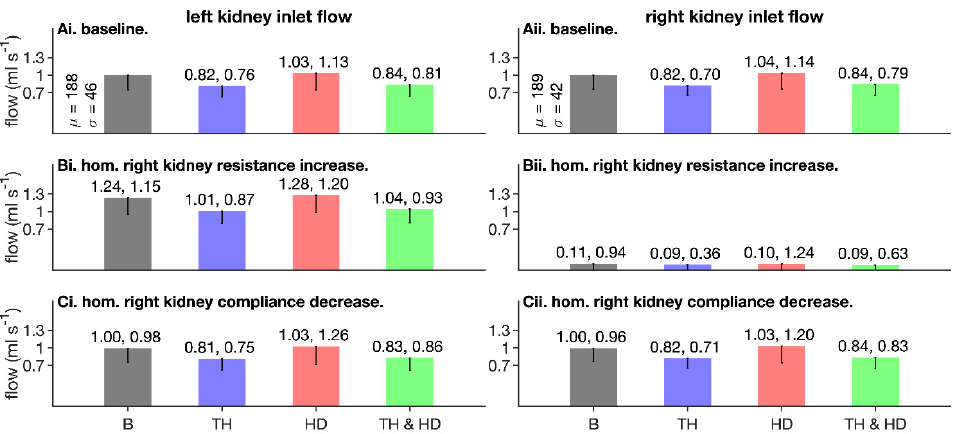
(Figure 7Ai,Aii), while it was increased by HD.